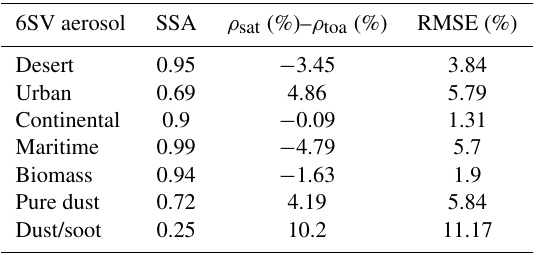
Table 6. Average difference between observed ρ sat and 6SV ρ toa for the 24 cases along with RMSE for each 6SV aerosol model. SSA at 500nm is also shown for each aerosol